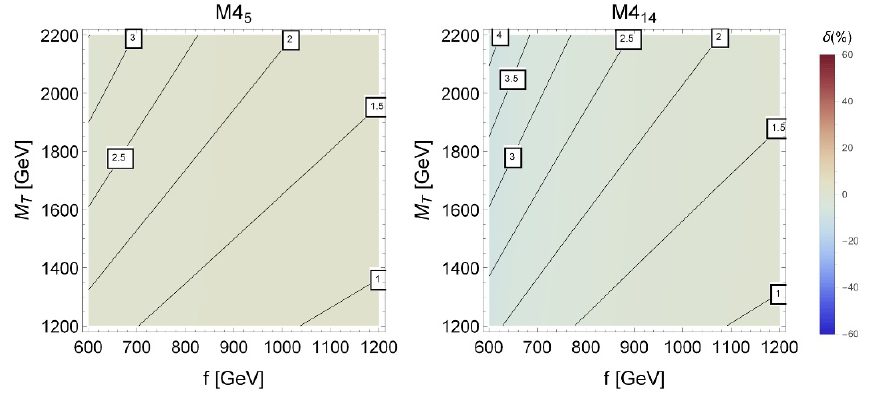
Figure 10 . The contour plots of (cid:14) ( p cut ) with sin 2 (cid:18) R = 0 : 1 and p cut = 200 GeV for each of the T T fourplet models with one top partner multiplet. The solid lines correspond to constant values of the coupling y . None of the parameter space on these plots result in (cid:20) t (cid:20) 0 : 8.